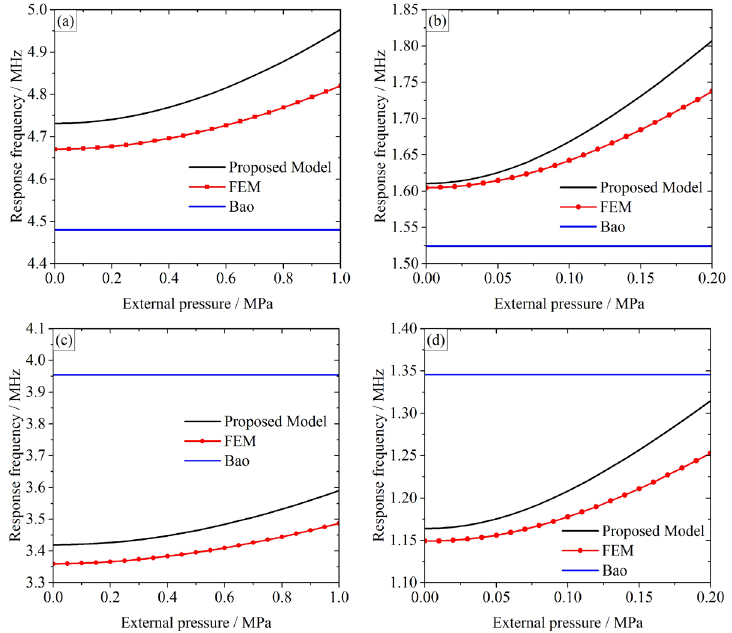
Figure 6. Response frequencies of three-layer CMUT membranes for different external pressures.